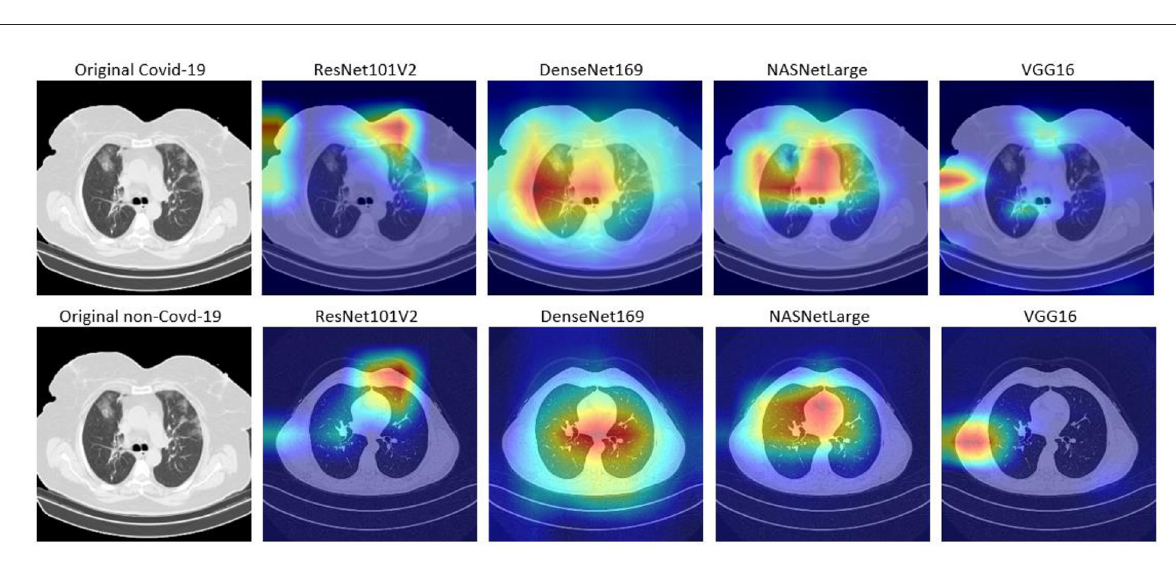
FIGURE6 Localization maps for ResNet101V2, DenseNet169, NASNetLarge, VGG16 (without data augmentation).